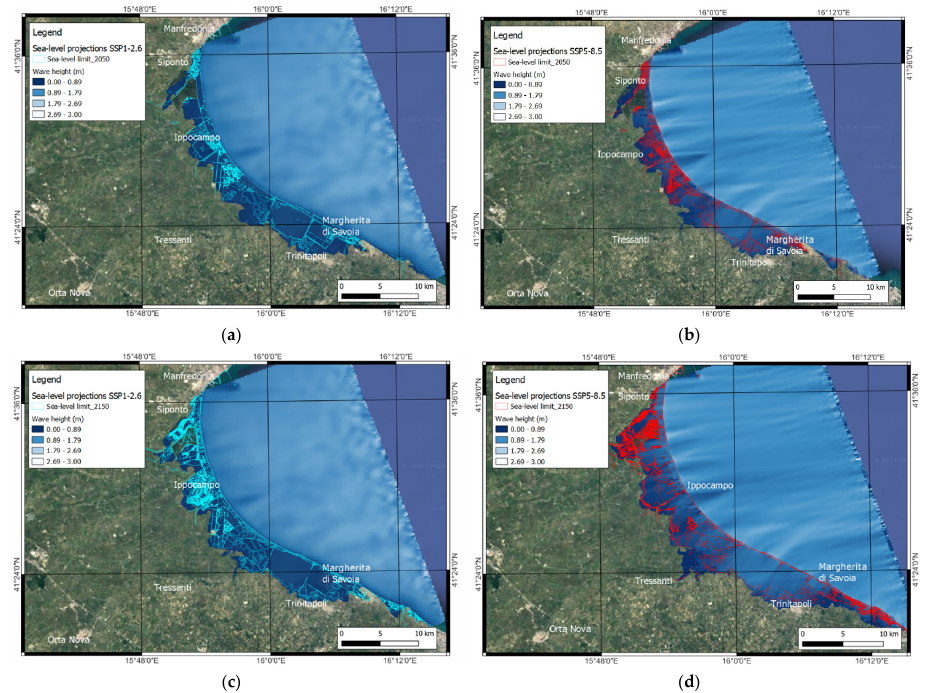
Figure 10. Potential inland flooding caused by propagation of the storm waves from offshore to inland in different SLR scenarios; boundary conditions of the storm event are reported in Supplementary Material. ( a ) Flooding in SSP1-2.6 scenario by 2050 (sea-level limit represented with light blue line); ( b ) flooding in SSP5-8.5 scenario by 2050 (sea-level limit represented with red line); ( c ) flooding in SSP1-2.6 scenario by 2150 (sea-level limit represented with light blue line); ( d ) flooding in SSP5-8.5 scenario by 2150 (sea-level limit represented with red